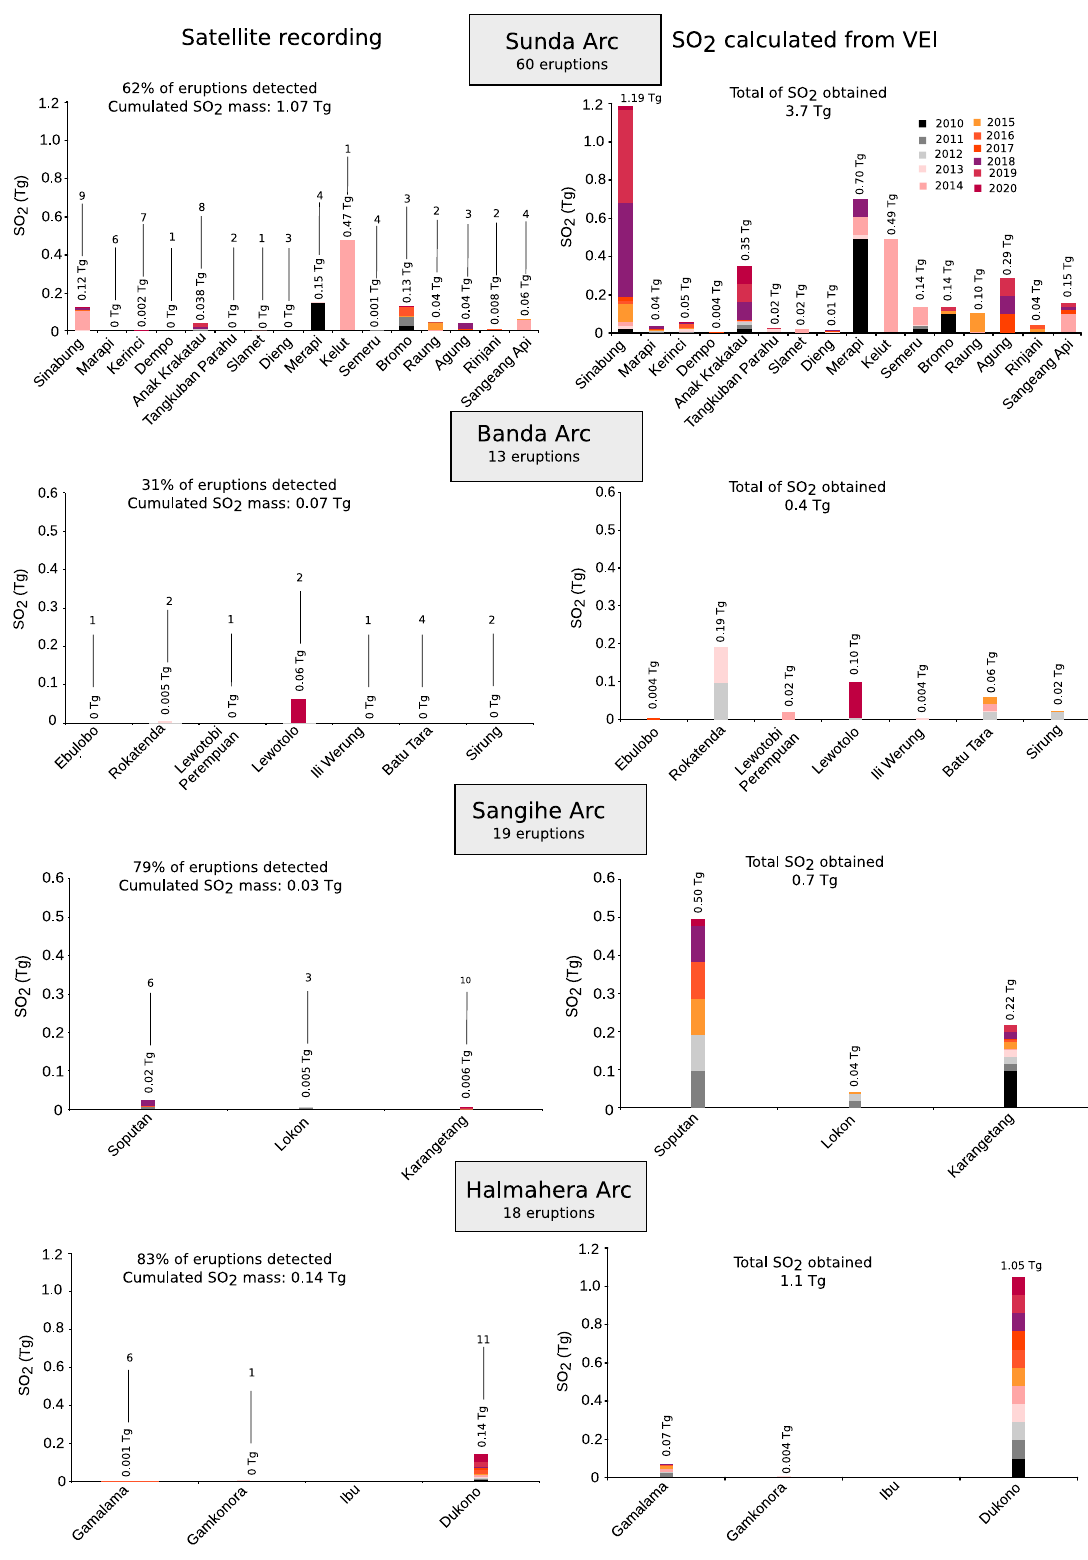
Fig. 3 The explosive SO 2 released per volcano over the period of 2010 – 2020. The names of the volcanoes that erupted over the decade are grouped by arc. The SO 2 mass per volcano obtained from satellite data are displayed on the left column whilst the right column shows the SO 2 amount obtained from the VEIs. The 0 Tg correspond to undetected eruptive emission by satellite sensors. The color code differentiates the years of observation and the height corresponds to the amount of SO 2 released per year. The number of eruptions per volcano is provided above each SO 2 mass value on the left column. Note that Dukono exhibits a continuous eruptive manifestation but only the largest event with ash fall on the nearby cities are considered.